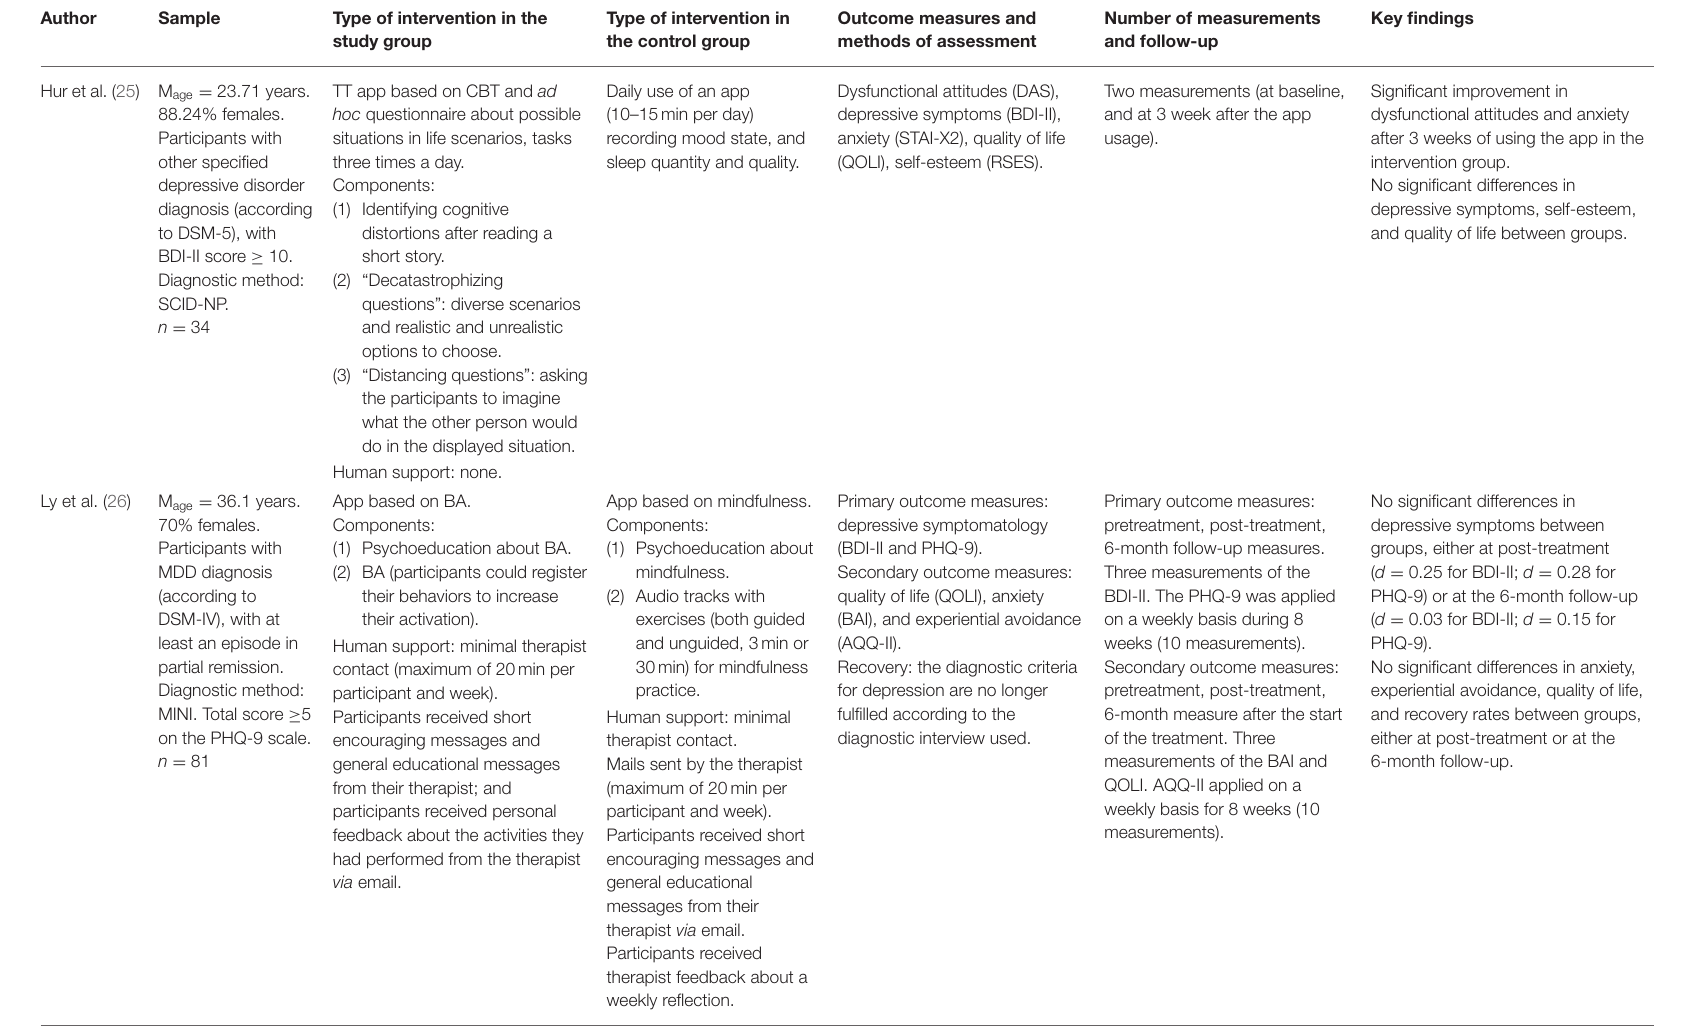
TABLE 1 | Main characteristics of the selected studies included in this systematic review to examine the efficacy of app interventions in patients with depressive